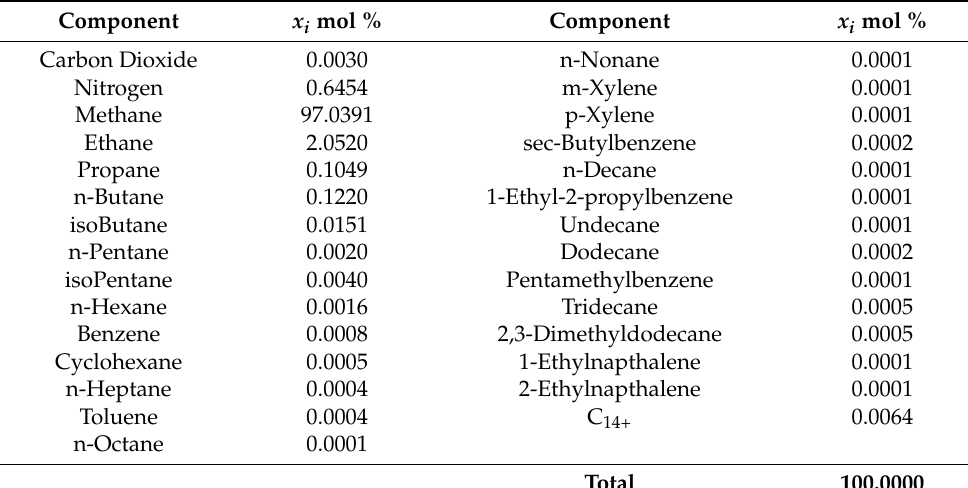
Table 5. Fully characterized composition of Sample 1 (Lean Gas).